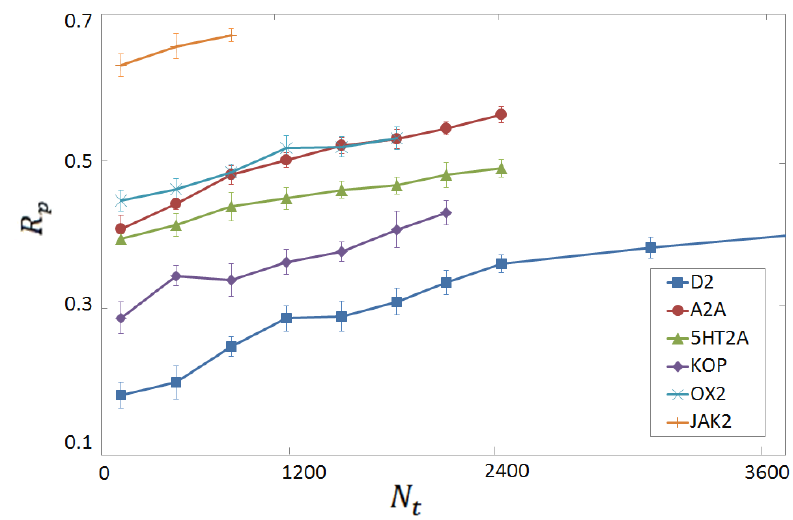
Figure 7. R p score for binding affinity predictions from six per-target FCNN SF’s, as a function of the training set size N t . Each SF is trained and tested on computer-generated complexes made from the protein indicated in the legend.